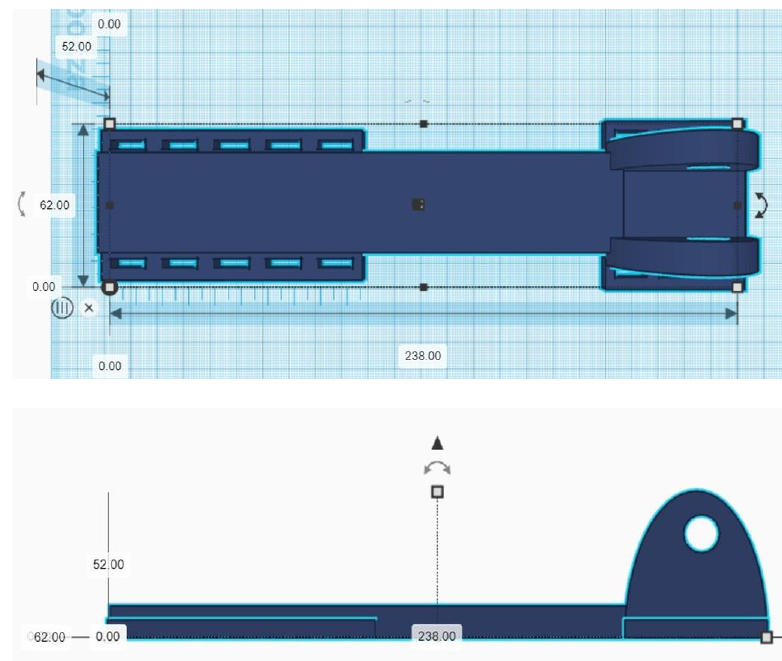
Figure 4. Output parameters of neural network.